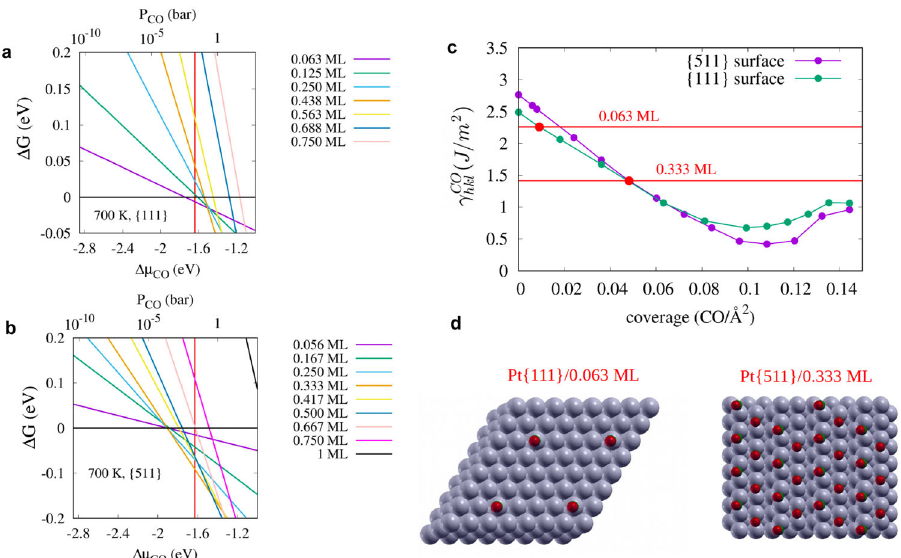
Fig. 5 Interfacial energy. Computed Gibbs free energy of adsorption per Pt atom on the surface, θ CO Δ G (eV/Pt atom), with θ CO being the number of adsorbed molecule with respect to the full coverage case, at 700 K as a function of the chemical potential for a the {111} surface and b the {511} surface. The two vertical red lines correspond to Δμ CO at 0.02 bar and 700 K with respect to 0 K. c Evolution of the interfacial energy γ CO hkl as a function of CO coverage ( i.e ., number of CO molecules adsorbed per Å 2 ) for (111) and (511) surfaces. d The coverage predicted for the two surfaces are shown as horizontal red lines and the corresponding con fi gurations are reported in